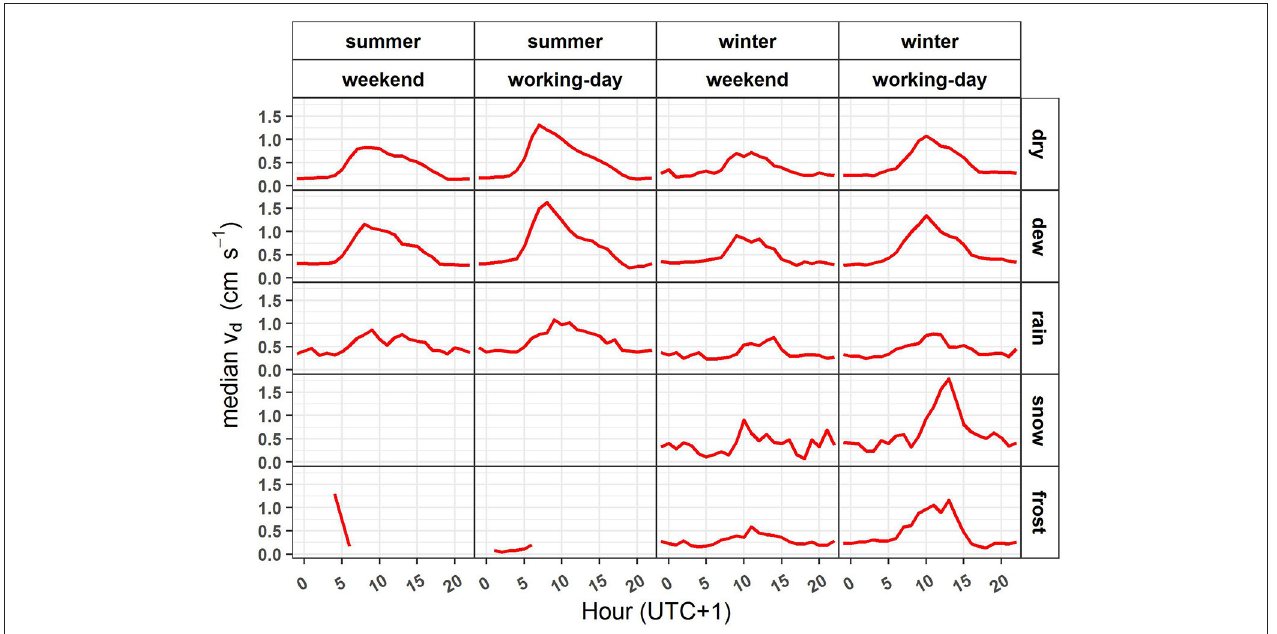
FIGURE 2 | Hourly median diurnal cycle in ozone deposition velocity ( υ d ) for 5 different canopy wetness categories/ surface classes (dry, dew, rain, snow and frost) during different seasons subdivided into weekend and working-weeks (in cm s − 1 ).